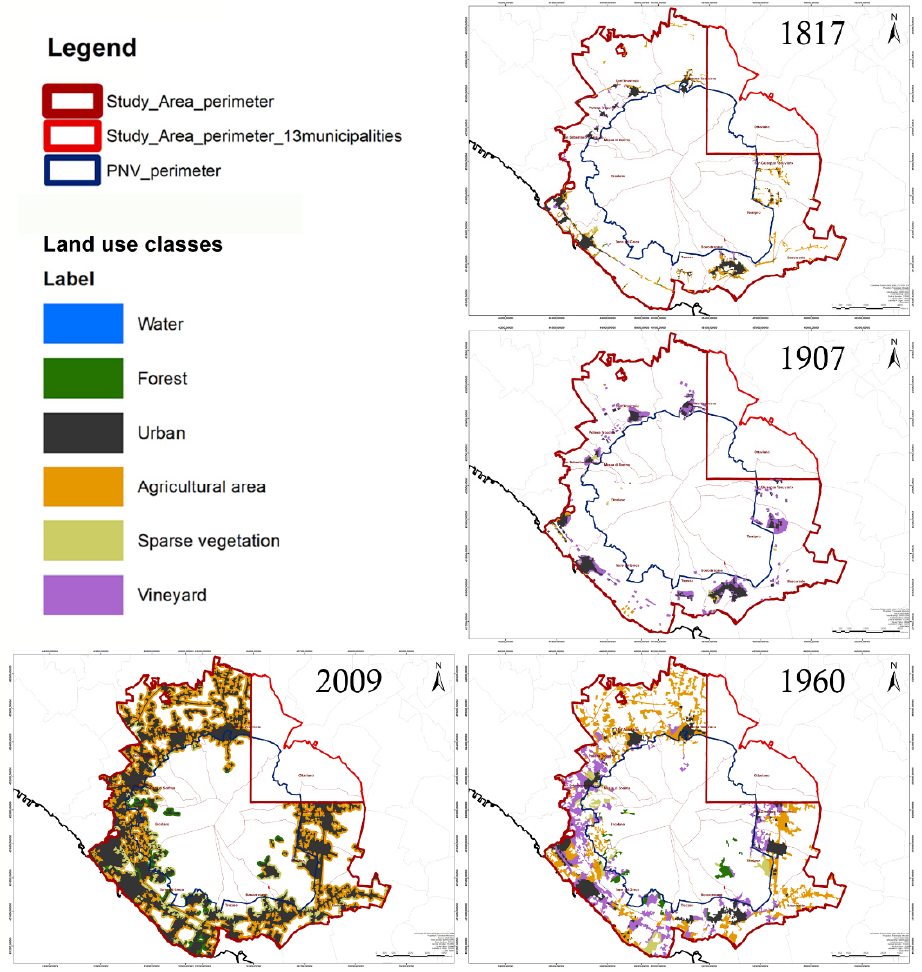
Table 3. Percentage of land cover classes of the total study area for the different time